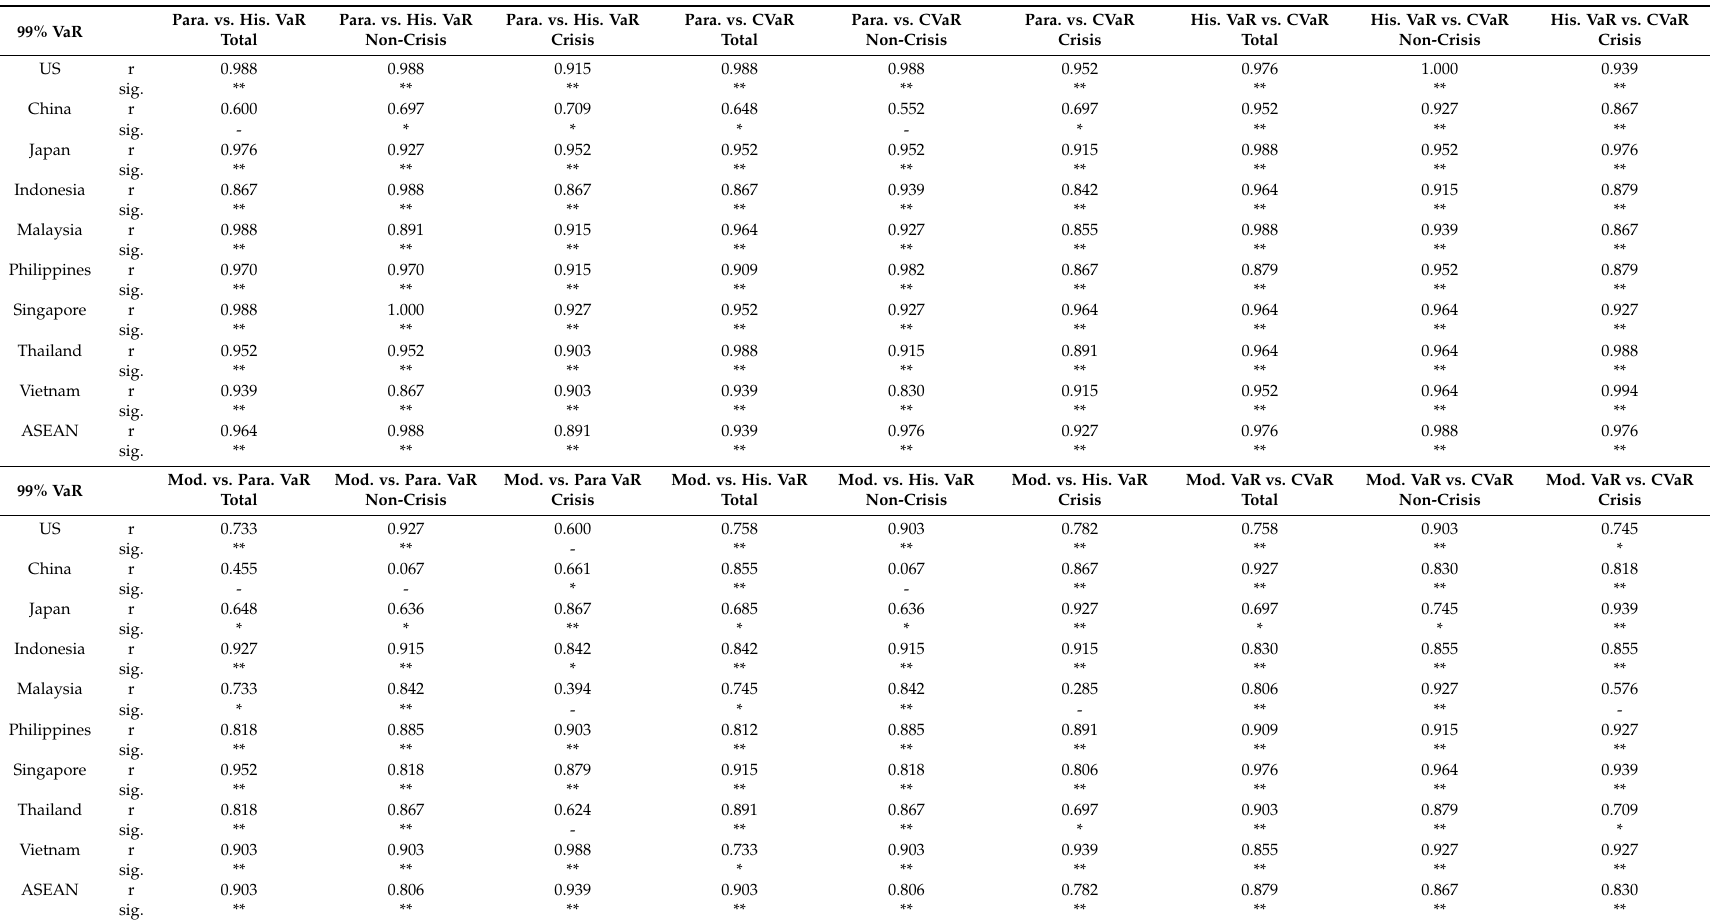
Table 3. Ranking correlation of industries between different metrics 99%